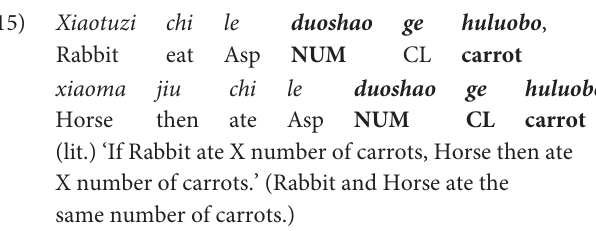
different ones. We use the same animal names as in (14) for ease of exposition).